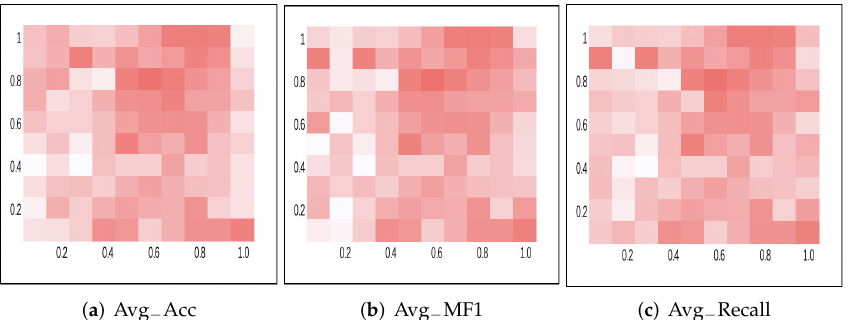
Figure 13. The influence of α 1 and α 2 on the Avg − MF1, Avg − Acc and Avg − Recall of the dataset